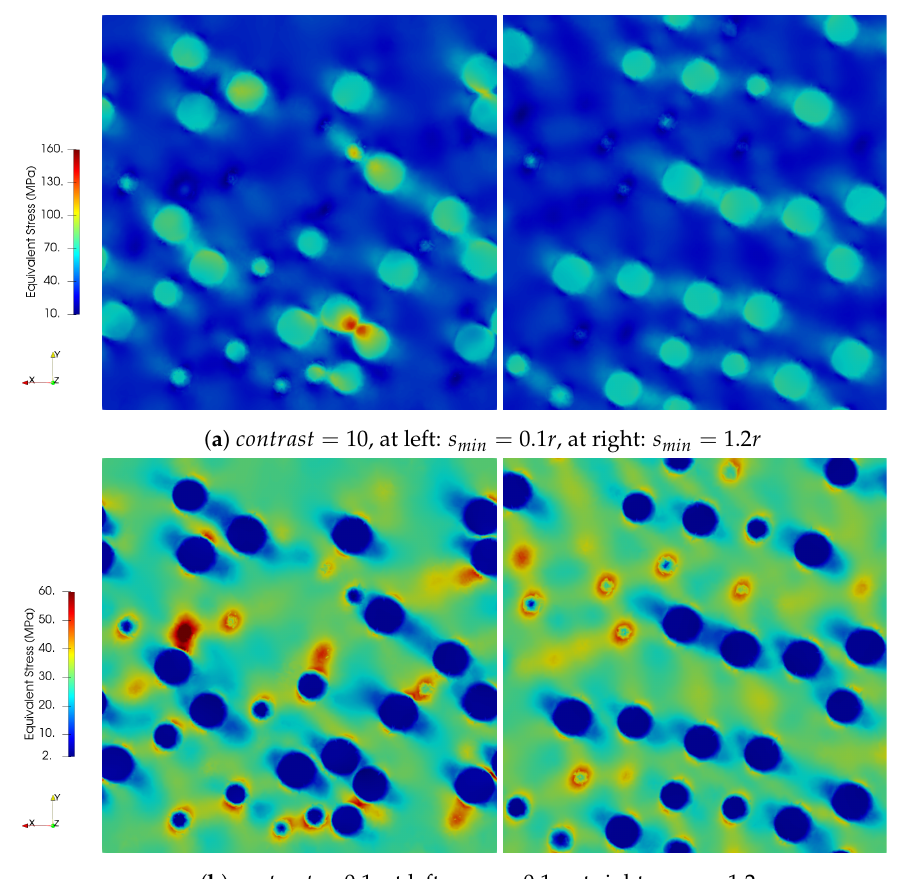
Figure A10. Local equivalent stress at SR = 10, f v = 13.4 % for extreme s min values and contrasts of 10 and 0.1—the cross-sectional views of an